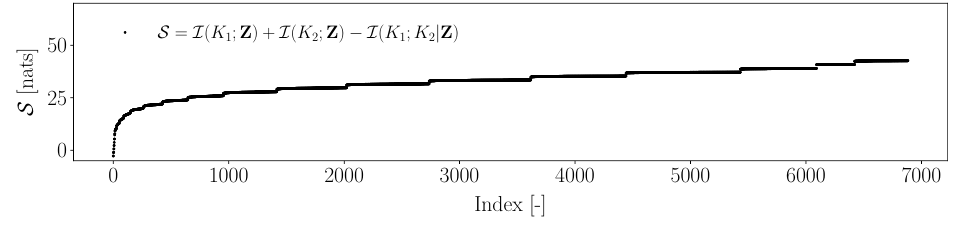
Figure 7. The variation of information criterion 6884 combinations sorted in increasing order of